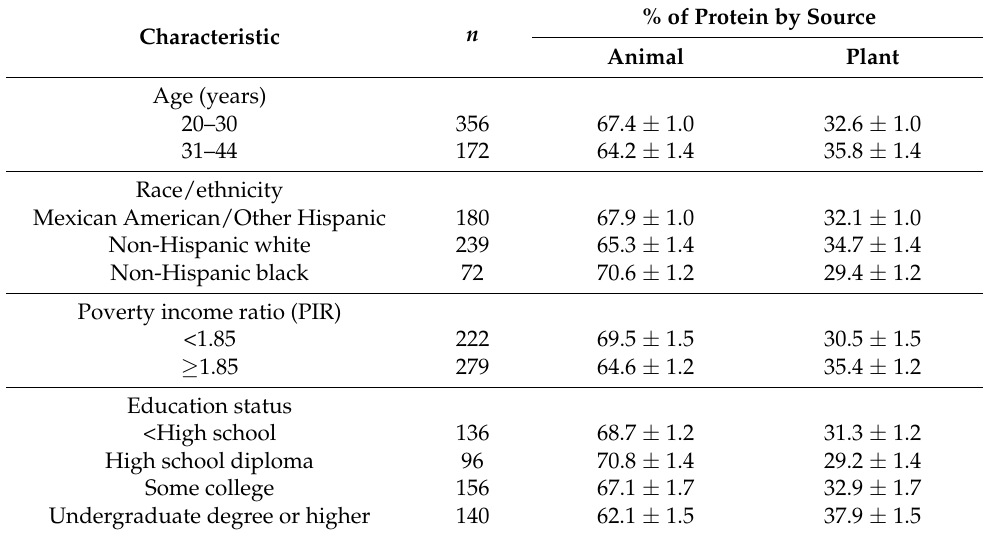
Table 5. Protein intake from animal vs. plant source by demographic characteristics among pregnant women ages 20–44 years in 2003–2012 National Health and Nutrition Examination